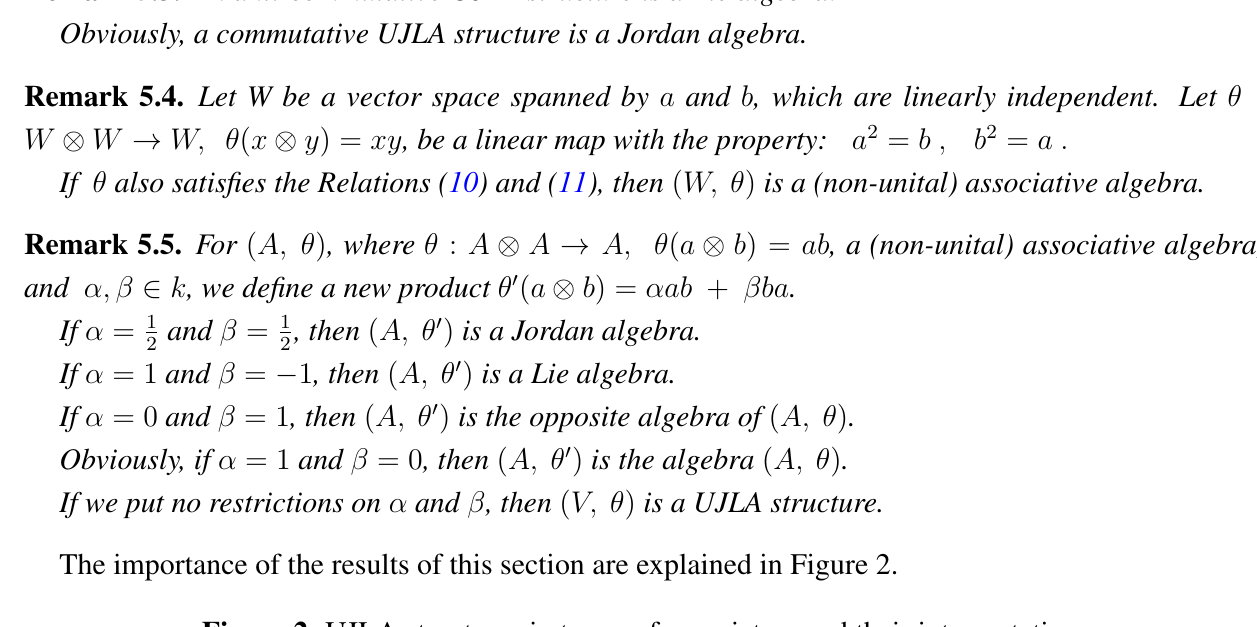
Figure 2. UJLA structures in terms of associators and their